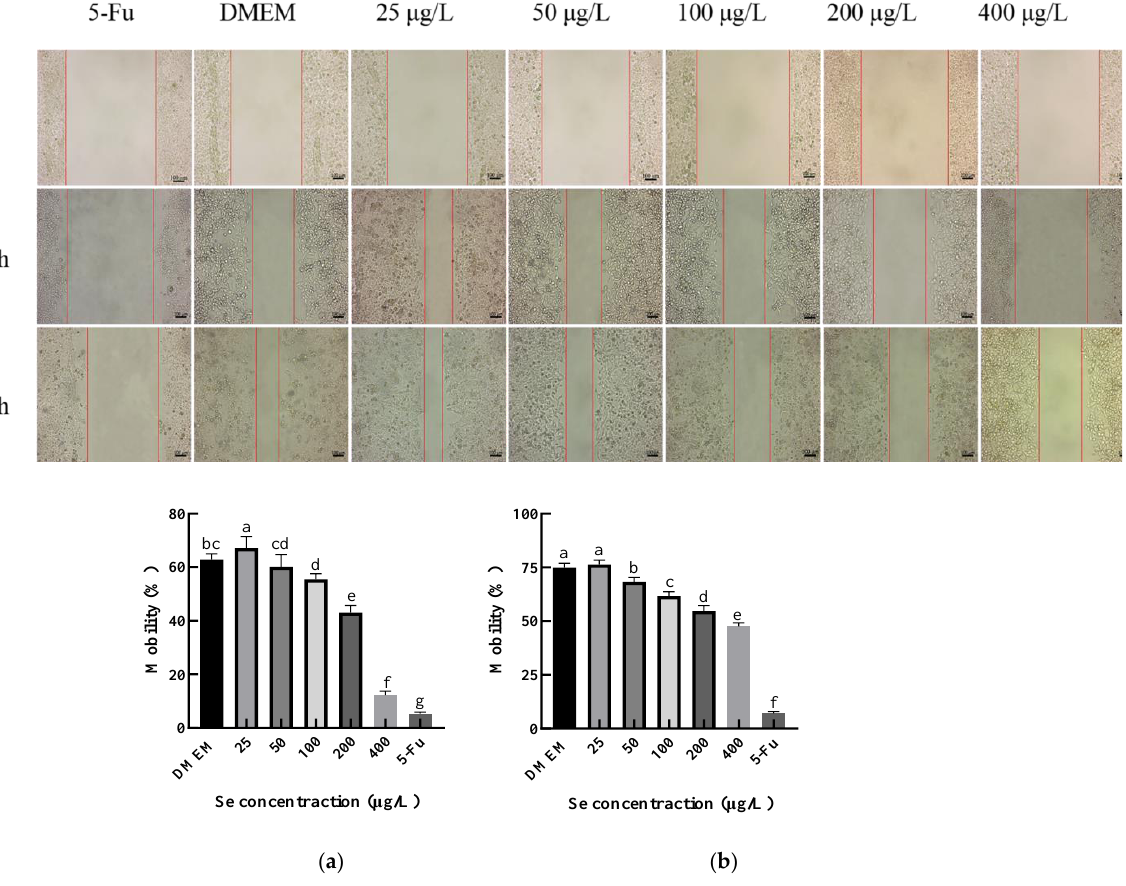
Figure 12. The effect of the SEP on the migration ability of the Hep G2 cells detected by scratch test. ( a ) Effect of the SEP on 24 h migration inhibition of the HepG2 cells; ( b ) Effect of the SEP on 48 h migration of the HepG2 cells. Notes: means with different lower-case letter differed significantly at p < 0.05.